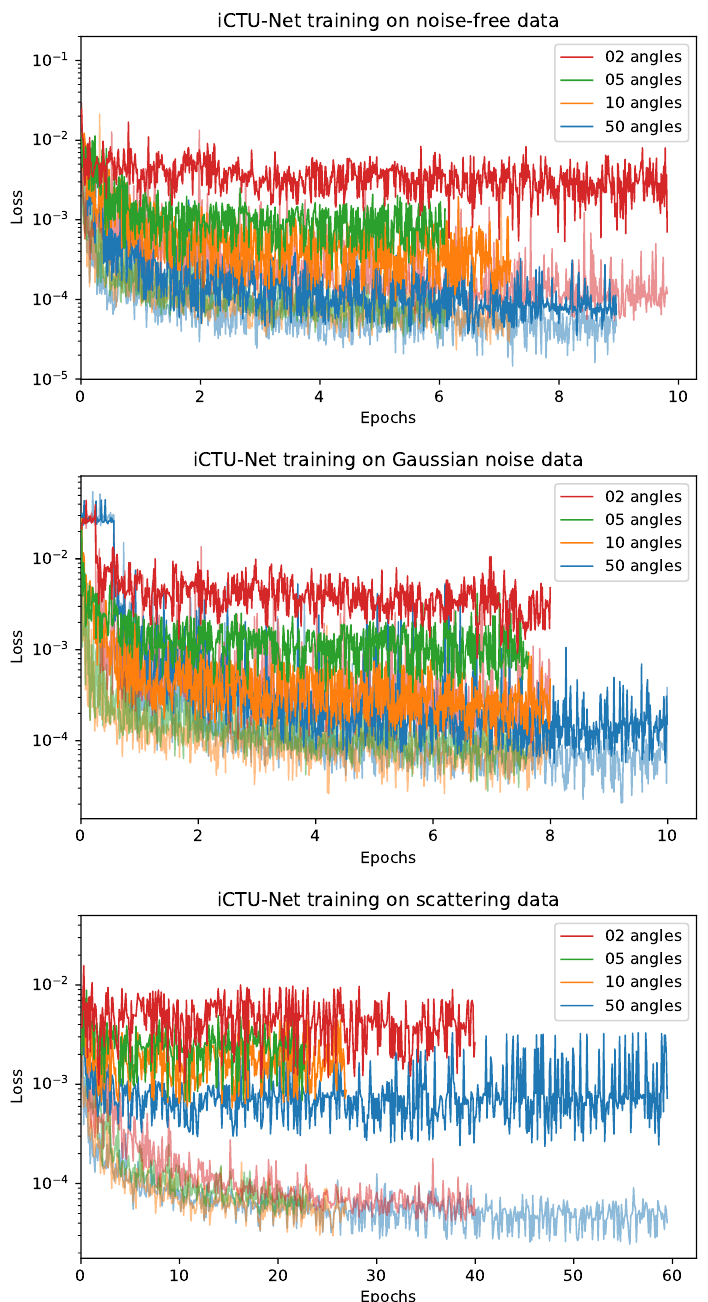
Figure A15. Training curves of iCTU-Net on the Apple CT dataset. Opaque lines: loss for a validation sample (after every 500-th step); semi-transparent lines: training loss (at every 500-th step). Duration of 20 epochs on full dataset: ≈ 3